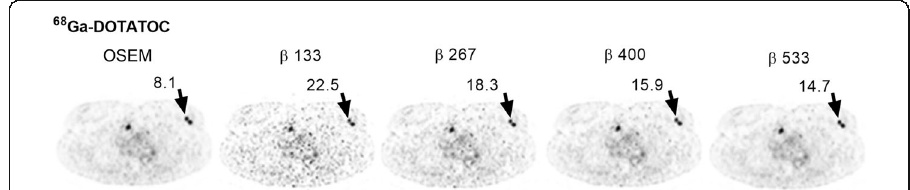
Fig. 2 Transversal 68 Ga-DOTATOC PET images of a patient with small intestinal neuroendocrine metastases. Images were acquired 72 min post-injection and reconstructed with 2 min/bp using OSEM (3 iterations, 16 subsets, 5-mm Gaussian post-processing filter) and BSREM with β -values of 133, 267, 400, and 533. Both reconstruction methods included TOF and PSF recovery. The administered activity was 1.8 MBqkg − 1 . The SUV max of the lesion (arrow) is shown for the respective